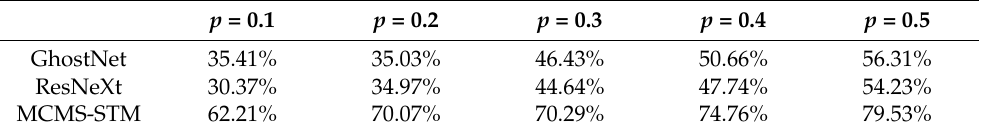
Table 9. The accuracies of the MCMS-STM and deep learning methods for dataset 2 under different numbers of training